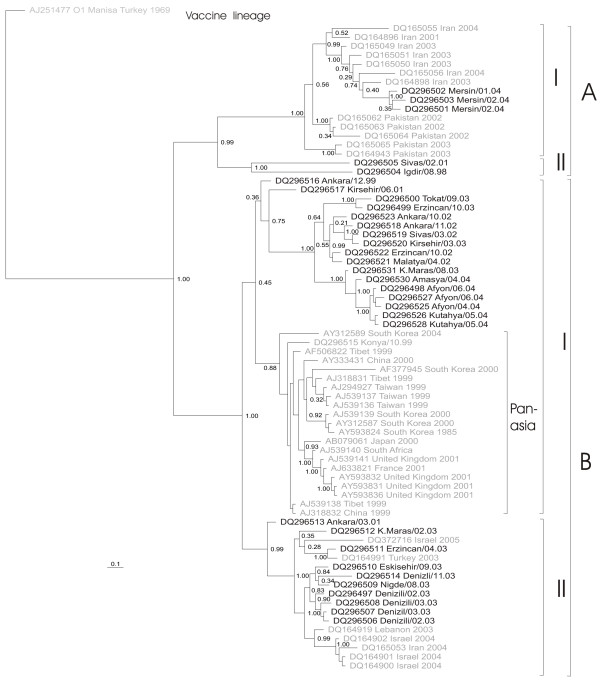
Bayesian phylogenetic analysis of the 1D (VP1) nucleotide sequence of Turkish serotype O isolates (black) and related published sequences (grey). The vaccine strain O1 Manisa is used as outgroup. Numbers on the nodes indicate clade credibility values. Formats of sequence name: accession number-country/province-year/month, year of collection.